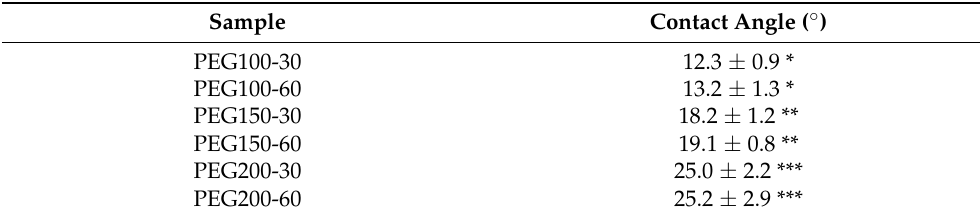
Table 3. Contact angles for the different samples with PEG. Asterisks indicate the statistical differ- ence